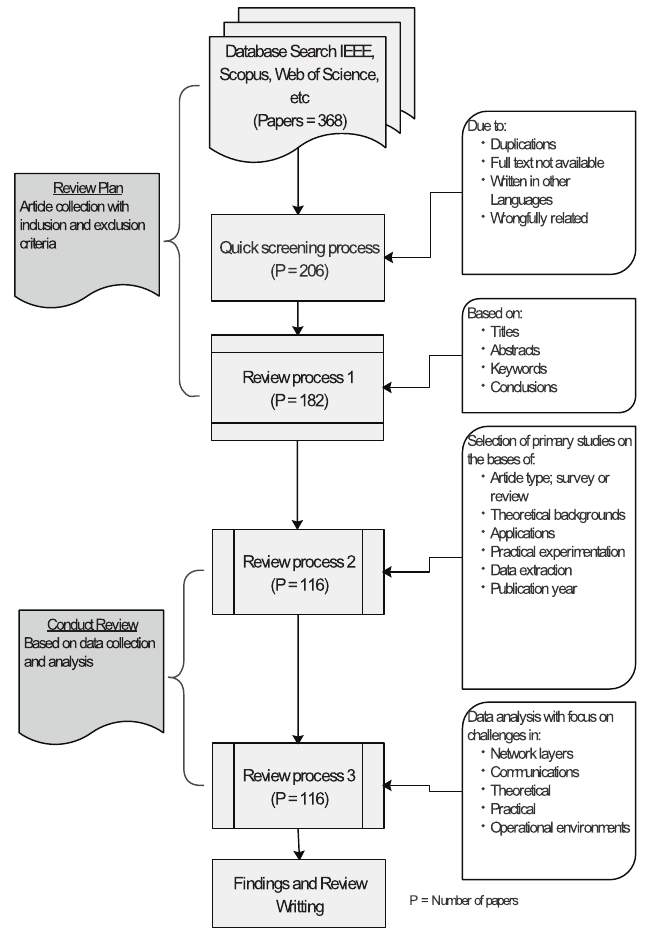
Figure 2. Data extraction